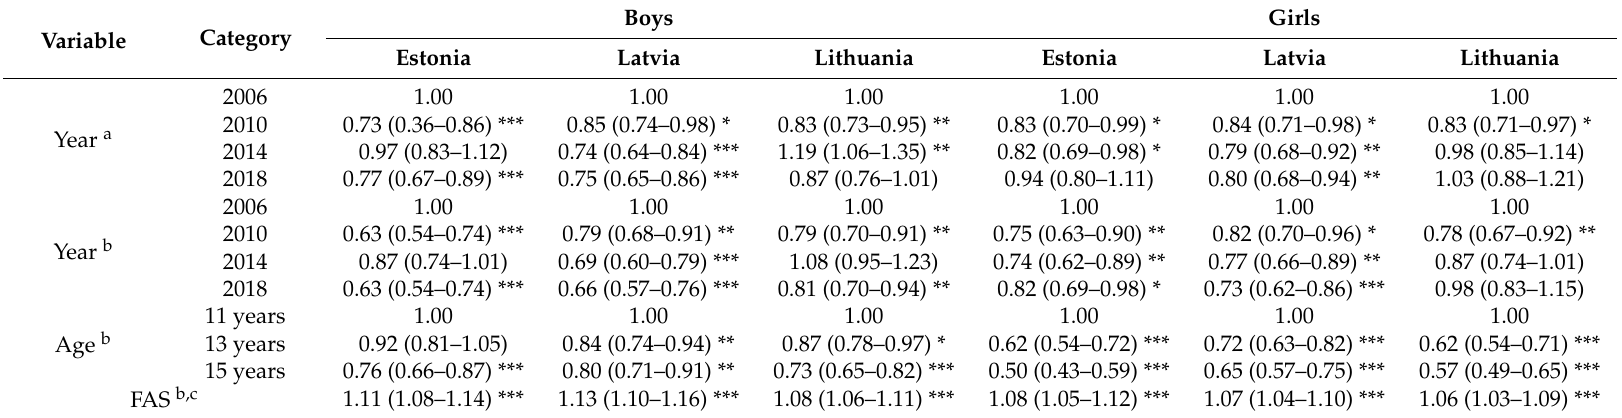
Table 3. Physical activity at least 60 min a day by survey year, age group and family a ffl uence (odds ratios and 95% confidence intervals).